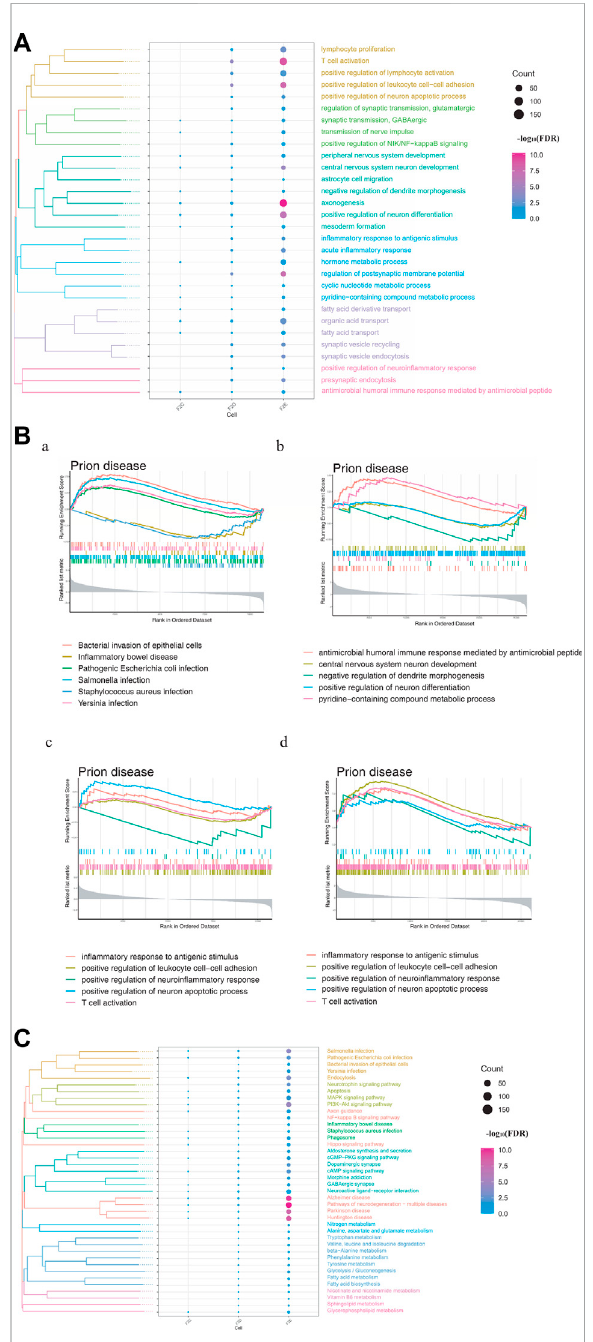
Enrichment analysis of differentially expressed genes (DEGs) in stroke and PSD patients. (A) . Biological processes: F2C represents the genes common to stroke and PSD; F2D represents genes that potentiallymediatePSDbasedonexcessivechangesinexpression during stroke recovery; F2E represents depression-speci fi c genes. (B) . GSEA. Panels (a,b) use common and speci fi c genes associated with strokeandPSDpatientsasthepresetgenesetforGSEA.Panels (c,d) use depression-speci fi c genes as the preset gene set for GSEA. (C) . KEGG pathway: F2C represents the genes common to stroke and PSD; F2D represents genes that potentially mediate depression based on excessivechangesinexpressionduringstrokerecovery;F2Erepresents ( Continued